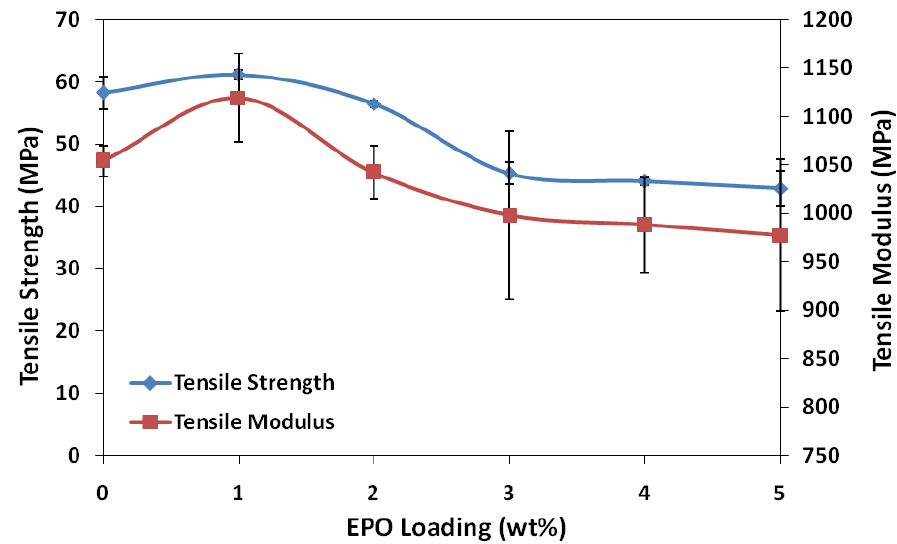
Figure 1. Tensile strength and modulus of neat PLA and PLA/EPO